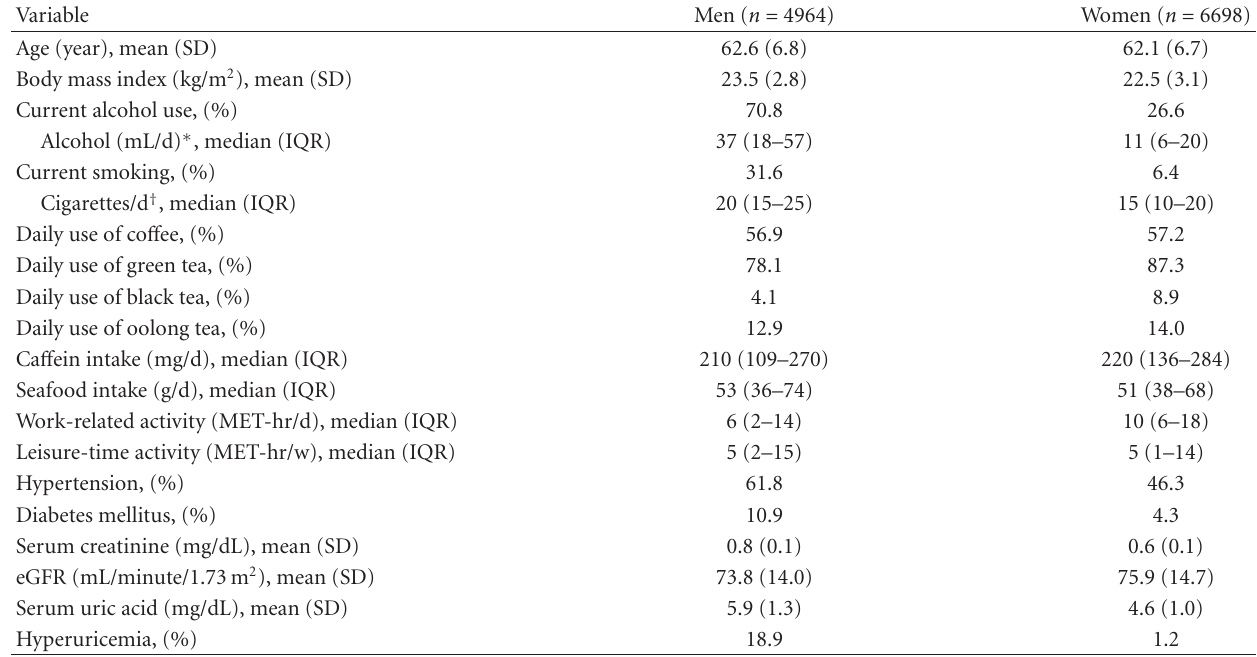
Table 1: Characteristics of the study subjects ( n =